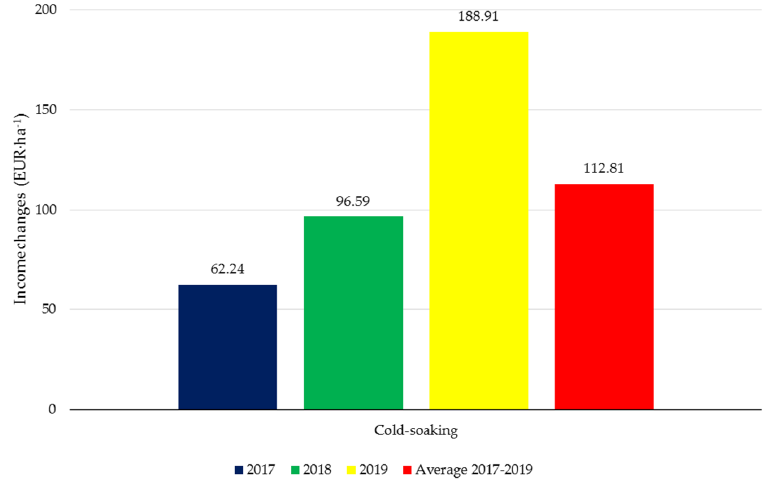
Figure 2. Income changes caused by the application of L. usitatissimum extracts in soybean cultivation. The values of the yield increase (EUR × ha − 1 ) represent the difference in income from soybean cultivation with biostimulator application and control.